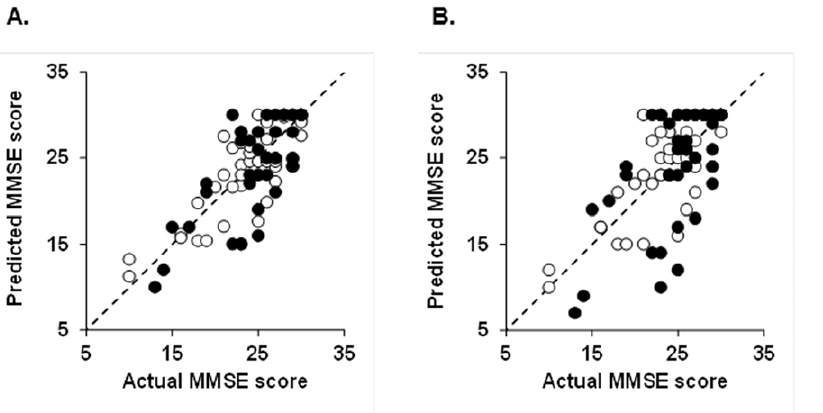
Figure 3. Scatterplots showing the relations between MMSE scores actually obtained and predicted MMSE scores. Predicted and actual MMSE scores at the third (open symbols) and fourth (filled symbols) sets of assessment by logarithmic model (A) and linear regression model (B). Logarithmic regression modeling estimated prediction of cognitive recovery to a more accurate degree than did the linear approach (logarithmic modeling, third set of assessments: R 2 =0.676, P , 0.0001, fourth set of assessments: R 2 =0.521, P , 0.0001; linear regression modeling, third set of assessments: R 2 =0.598, P , 0.0001, fourth set of assessments: R 2 =0.370, P , 0.0001).